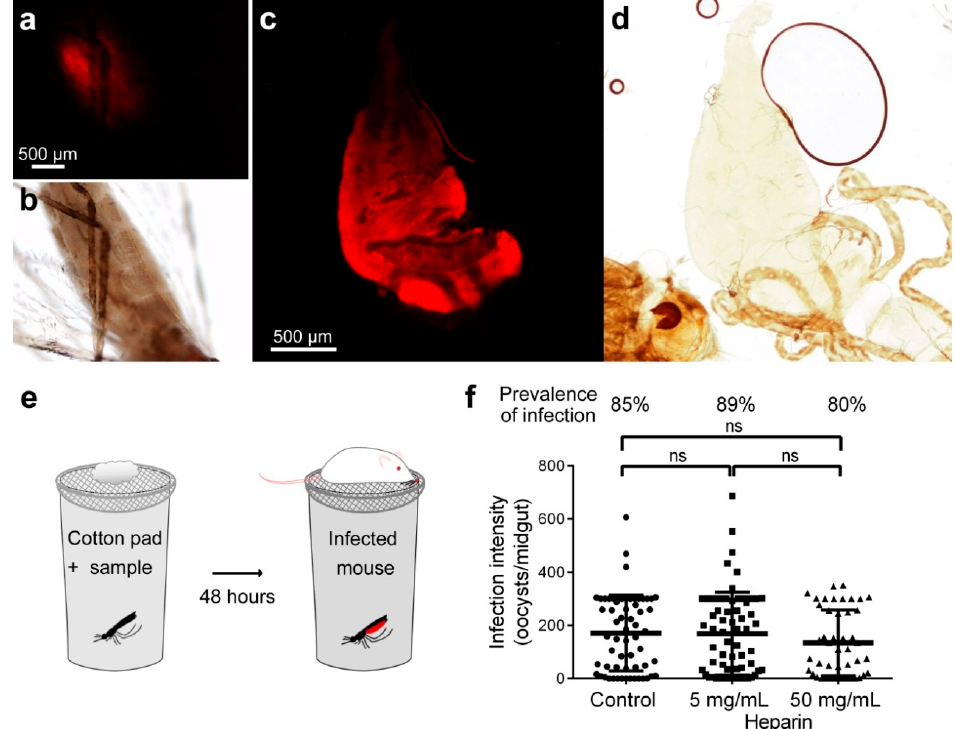
Figure 2. Effect on ookinete development of heparin fed to mosquitoes by sugar meal. ( a , c ) Fluorescence detection in ( a ) intact abdomen and ( c ) dissected midgut of heparin ‐ Cy5 fed to A. stephensi female mosquitoes in a sugar meal. ( b , d ) Bright field images of the microscope fields in panels a and c , respectively. ( e ) Depiction of the method for sugar feed used in mosquito assays. ( f ) Effect on parasite development of heparin delivered by sugar swaps. ns: not significant.